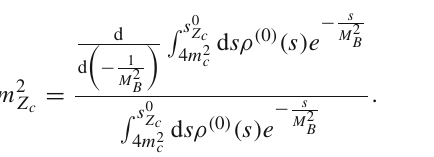
Fig. 2 The dependence of the mass m Z (cid:14) = 4 . 6GeV (dashed s 0 Z c